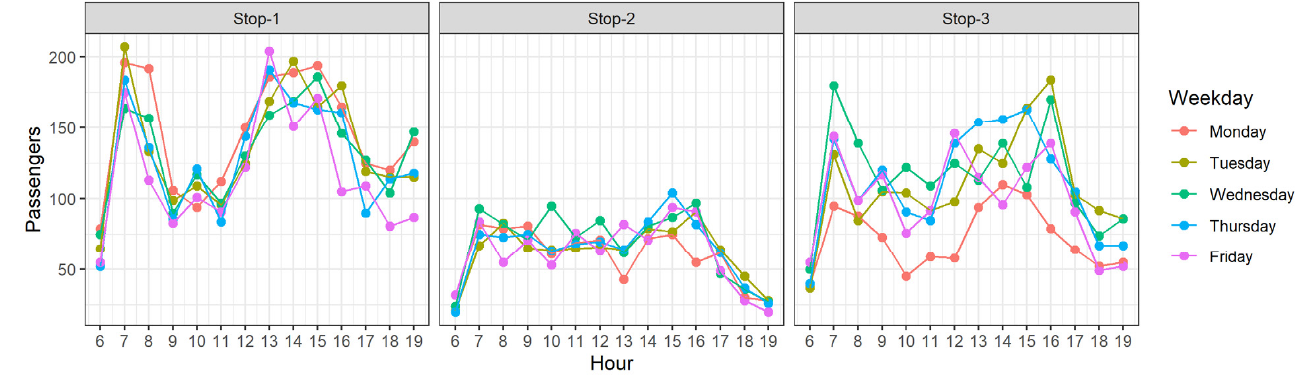
Figure 9. Hourly distribution of counted passengers on tram stops according to the weekday.